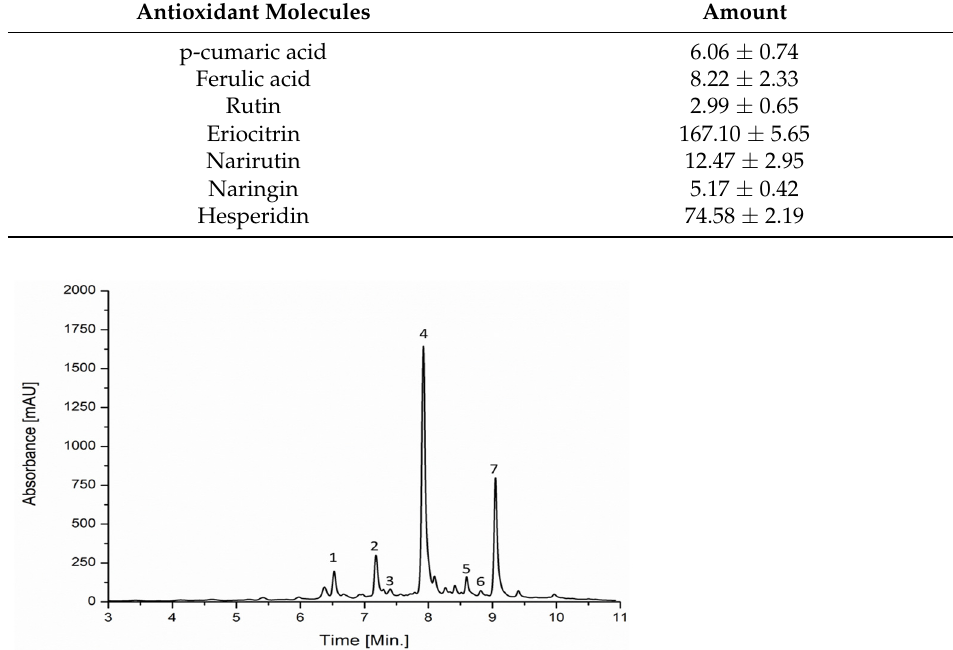
Figure 2. Example of chromatographic profile: peak designation was: (1) p-cumaric acid, (2) ferulic acid, (3) rutin, (4) eriocitrin, (5) narirutin, (6) naringin, (7) and hesperidin. acid, (3) rutin, (4) eriocitrin, (5) narirutin, (6) naringin, (7) and Table 3. Antioxidant characterization of the extract analyzed by UHPLC (mg/kg).